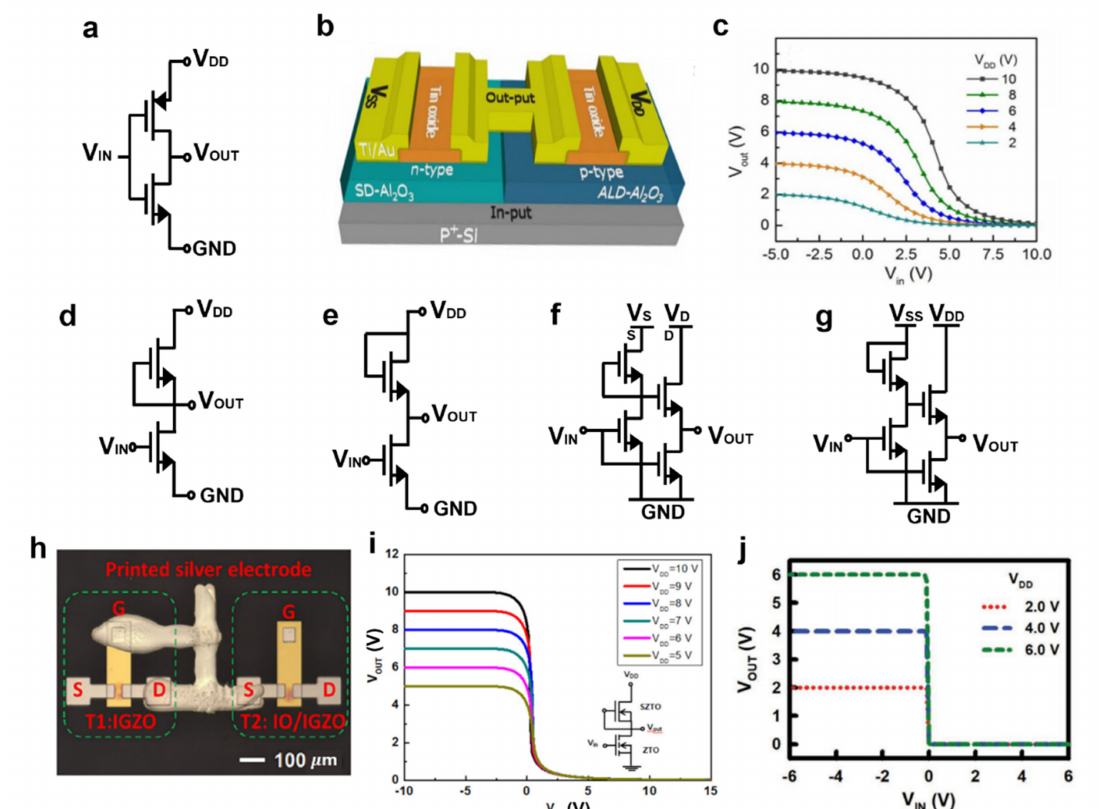
Figure 5. ( a ) Schematic diagrams of CMOS inverter structure; ( b ) Conceptual CMOS inverter device structure in one material; ( c ) Transfer characteristics of the CMOS inverter (adapted from [89] with permission from Springer Nature); ( d ) Schematic diagrams of a zero-VGS inverter structure; ( e ) Schematic diagrams of a diode-load inverter structure; ( f ) Schematic diagrams of a Pseudo-D inverter structure; ( g ) Schematic diagrams of a Pseudo-E inverter structure; ( h ) Optical image of a zero-VGS inverter (adapted from [90] with permission from Elsevier B.V.); ( i ) ZTO TFTs transfer characteristics of a zero-VGS inverter (adapted from [91] with permission from AIP Publishing); ( j ) IGZO TFTs with ZAO insulator transfer characteristics of a zero-VGS inverter (adapted from [92] with permission from John Wiley and